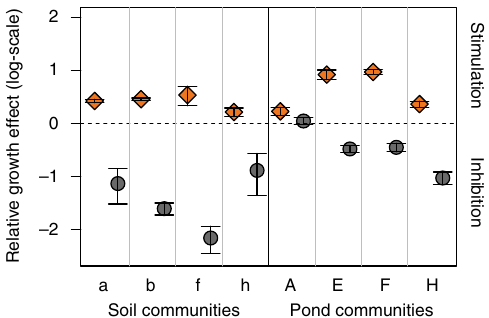
Fig. 4 Heterologous pyoverdines promote or inhibit growth of receiver strains. Eight pyoverdine non-producers, each originating from a different community, were supplemented with puri fi ed pyoverdine from either (i) a strain, which showed a stimulatory effect ( orange diamonds ) in the supernatant assay, or (ii) a strain, which showed neutral (two cases) or inhibitory (six cases) effect ( grey circles ) in the supernatant assay. The dashed line depicts neutral effects, whereas values greater or smaller than zero indicate cases of growth stimulation or inhibition, respectively, relative to conditions where receivers grew without heterologous pyoverdine. The data show a good match between the supernatant and the pyoverdine cross-feeding assays, suggesting that it is indeed heterologous pyoverdine that triggers the patterns of growth stimulation and inhibition reported in Fig. 3. Data points show means ± 95% con fi dence intervals across fi ve replicates. Data were ln-transformed